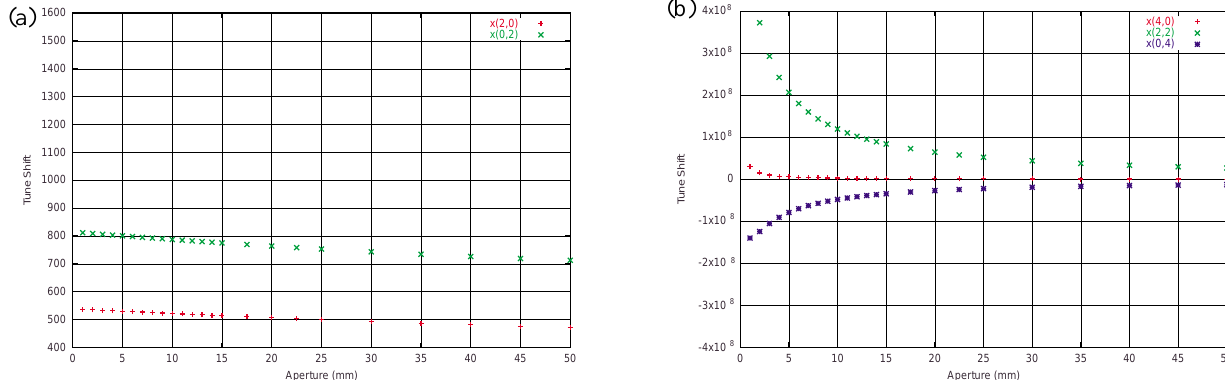
FIG. 7. (Color) (a) Convergence to a constant of the second-order and (b) blowup of the fourth-order amplitude dependent tune shifts in the x tune. The fringe field shape is given by the default Enge